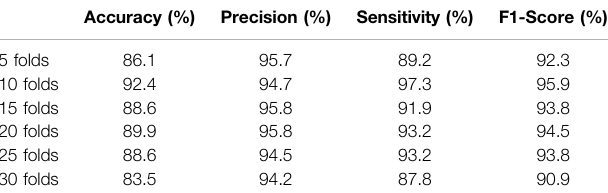
TABLE 5 | Performance of KNN classi fi er.